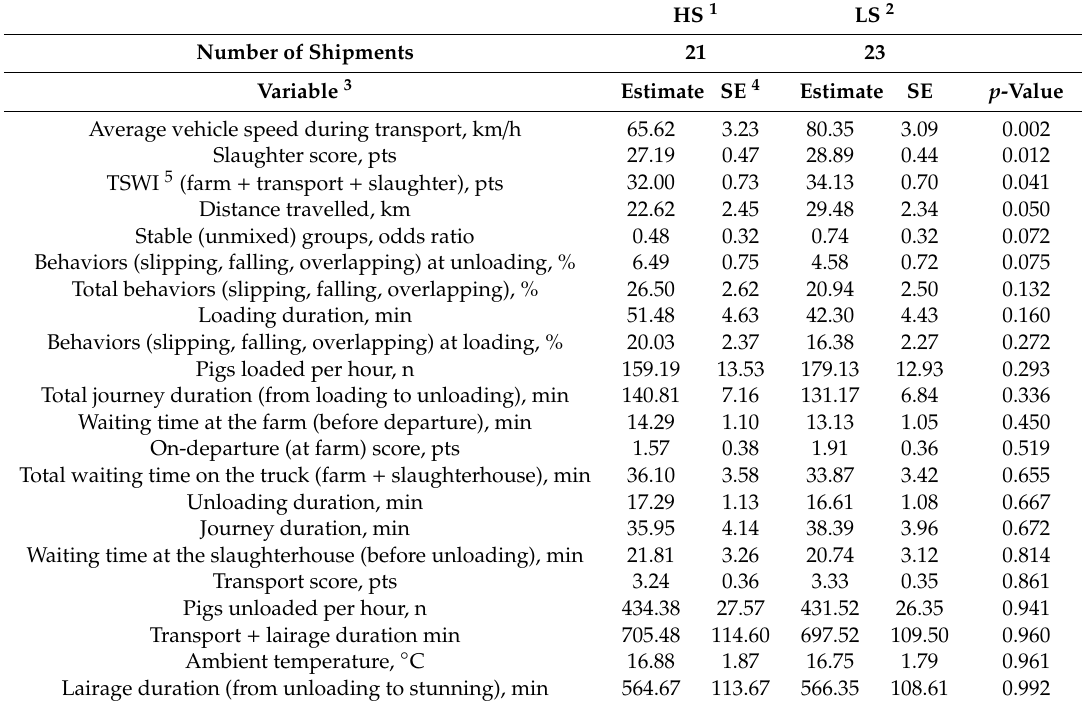
Table 3. Di ff erences in the measured transport and slaughter variables between the two clusters. Variables are sorted by significance level in decreasing order of significance (from higher to